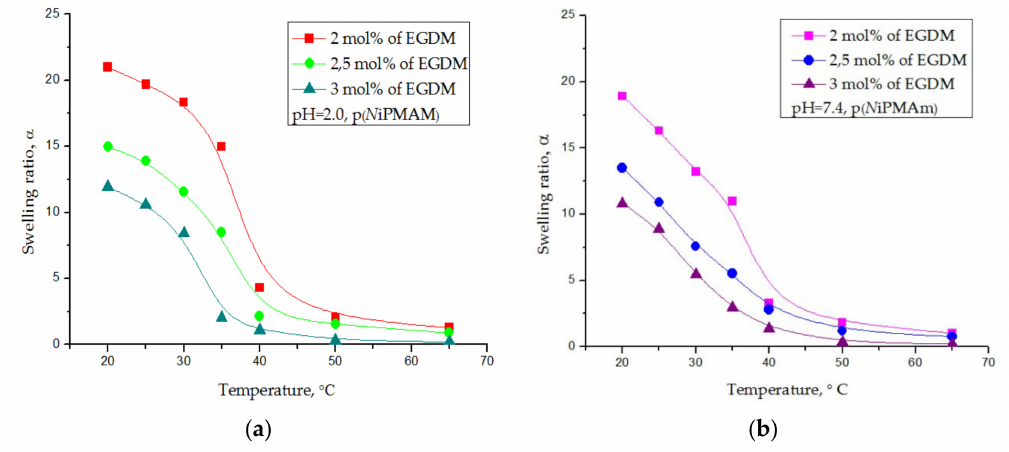
Figure 8. Swellingratio, α , forpoly( N -isopropylmethacrylamide)hydrogelsdependingonthetemperature in fluid with pH-values of ( a ) 2.0 and ( b )